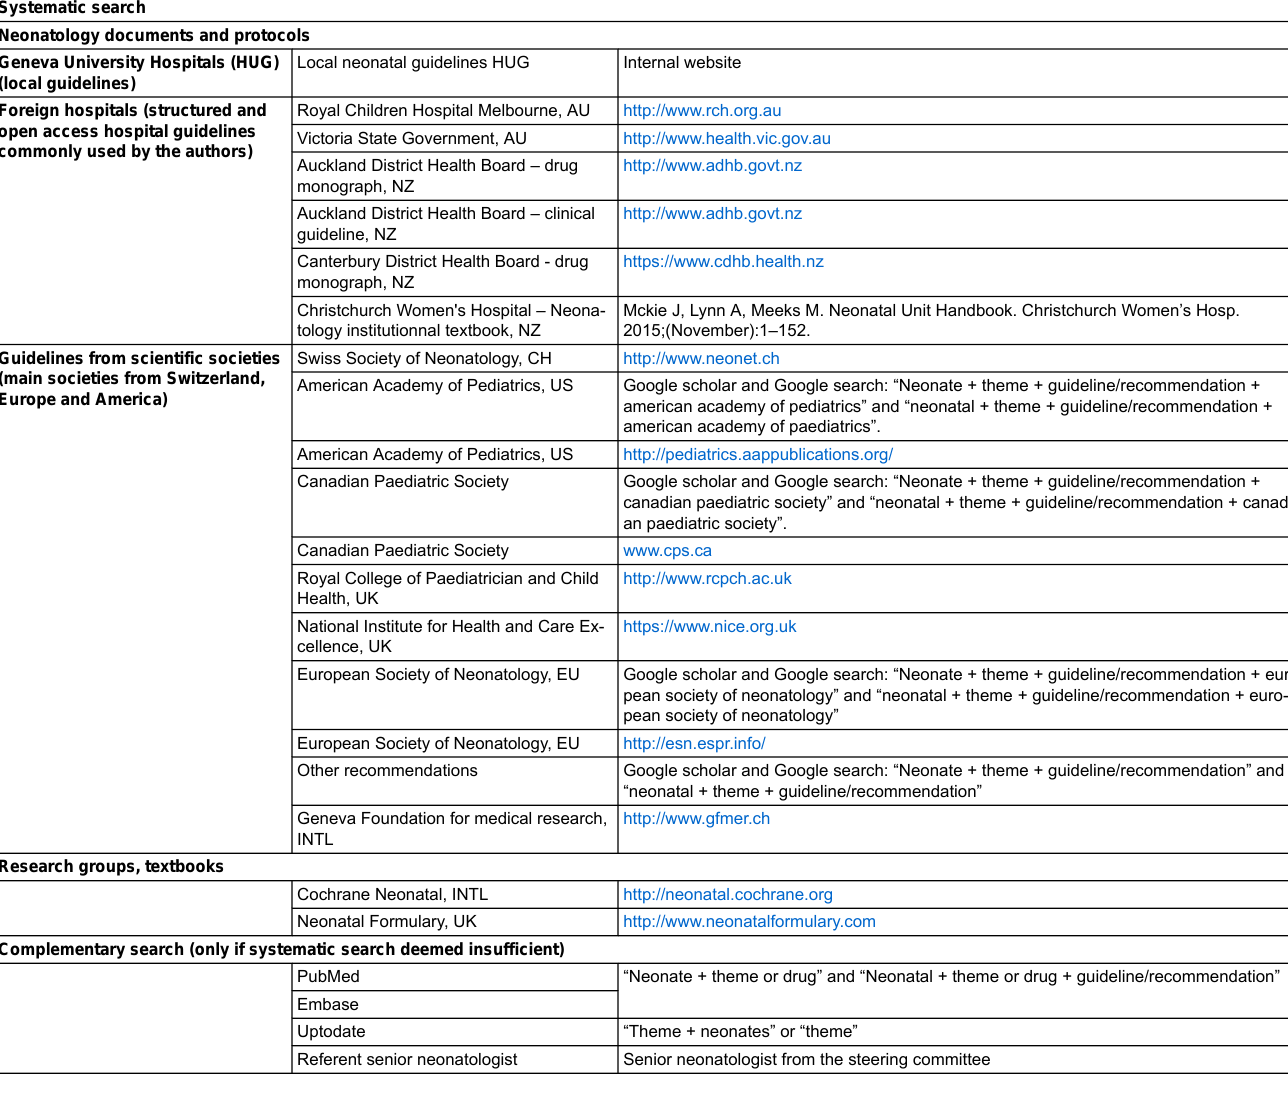
Table 1: Sources consulted in the literature